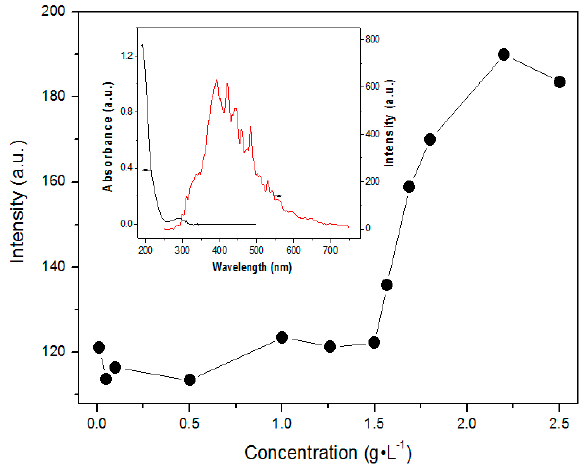
Figure 3. Plot of the Rayleigh scattering intensity at 390 nm versus concentration of the mPEG-maleic rosin. The inset is the Rayleigh light scattering and absorption spectra of the mPEG-maleic rosin copolymer solution.